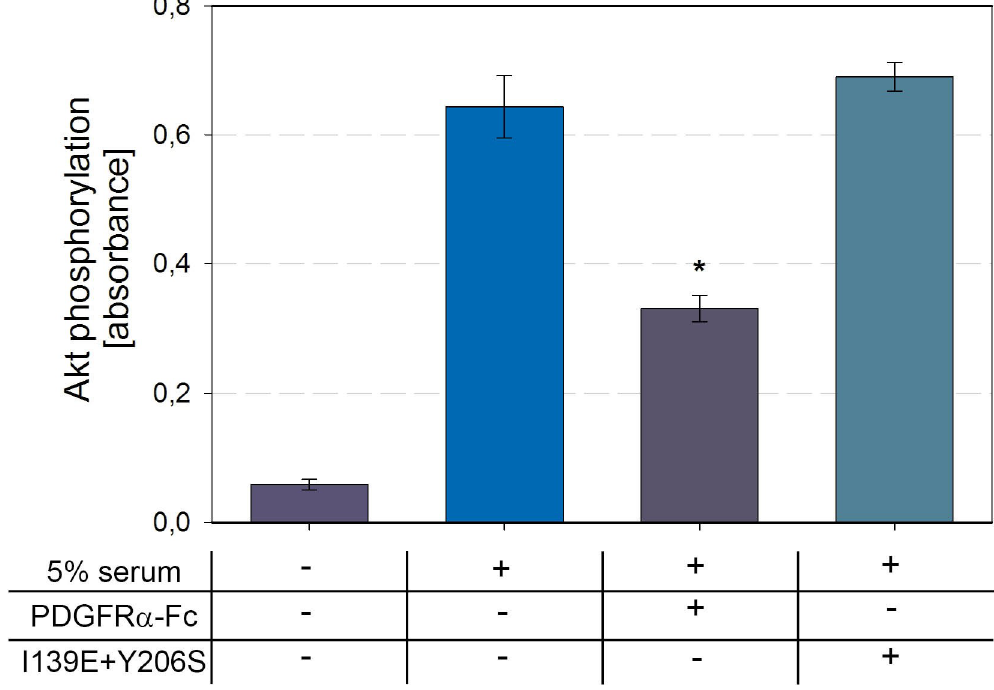
Fig 8. Serum induced cellular signaling is unaffected by treatment with the PDGFR α -Fc I139E + Y206S mutant. To test for cellular signaling under more physiological conditions, the effect of PDGFR α -Fc wild type and I139E + Y206S double mutant on serum-induced phosphorylation of Akt was measured. A pool of sera from 3 donors was preincubated with 562 ng/ml of soluble receptors before stimulation of fibroblasts. The absolute amount of Akt phosphorylation was measured using a commercial ELISA. Shown are the mean values for 3 experiments testing 2 independent protein preparations. The error bars indicate standard error of the mean. The asterisk indicates that only PDGFR α -Fc wild type but not the I139E + Y206S mutant significantly interfered with serum induced signaling as determined by unpaired t-tests comparing the response of untreated serum to the treated sera.